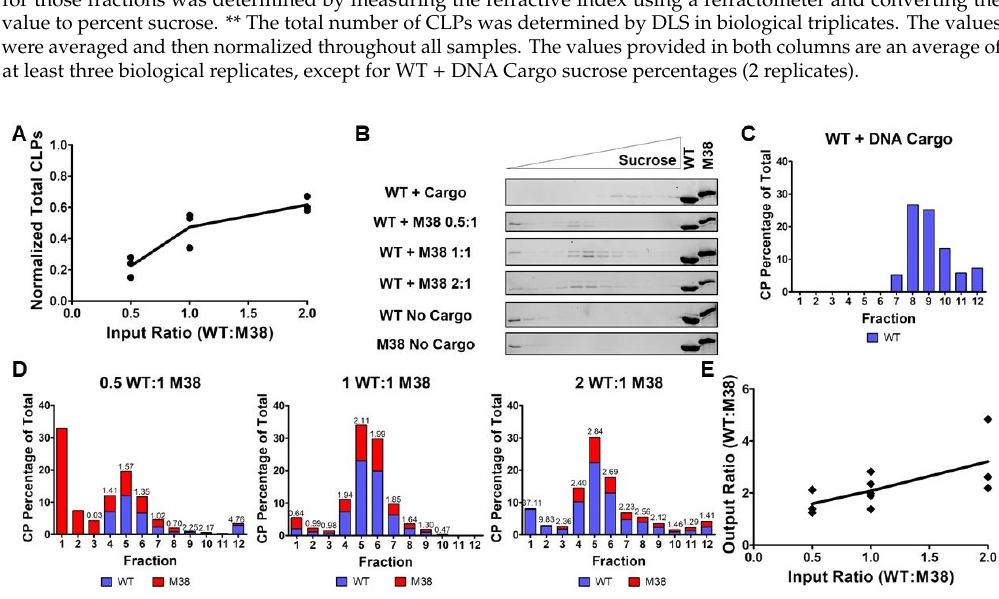
Figure 4. The amount of WT and M38 capsid proteins in the WT + M38 CLPs varies with input ratio. ( A ) As the input ratio of WT:M38 CP increases (by varying WT CP and keeping M38 constant), the number of CLPs formed increases, as determined by DLS. The line represents the mean of the three biological replicates (circles). The numbers are normalized according to Table 1. ( B ) The individual capsid proteins, WT + DNA cargo CLPs, and WT + M38 CLPs were separated over a sucrose gradient using ultracentrifugation. The gel for WT + DNA cargo CLPs is a representative gel of two biological replicates, and the gels for WT + M38 CLPs at all ratios are representative of at least three biological replicates. The control lanes contained 1.5 µ g concentrated protein (gels 2 and 4, corresponding to ratios 0.5:1 and 2:1, respectively) or 3 µ g concentrated protein (all other gels). ( C , D ) Quantification of protein signal from the gels in ( B ) using densitometry (WT CP in blue; M38 CP in red). Each graph represents an average of at least three biological replicates except WT CP + DNA cargo, which represents two replicates; each data point was normalized so that total protein signal in each graph would equal 100%. Above the bars is the ratio of WT:M38 CP in the fraction and is the average of at least three biological replicates. ( E ) As the input ratio increases, the output ratio of the assembled CLPs also increases in a linear fashion. The line represents the mean of the three-to-five biological replicates (diamonds). The output ratios plotted are for fraction 5, as determined in panel ( D ).